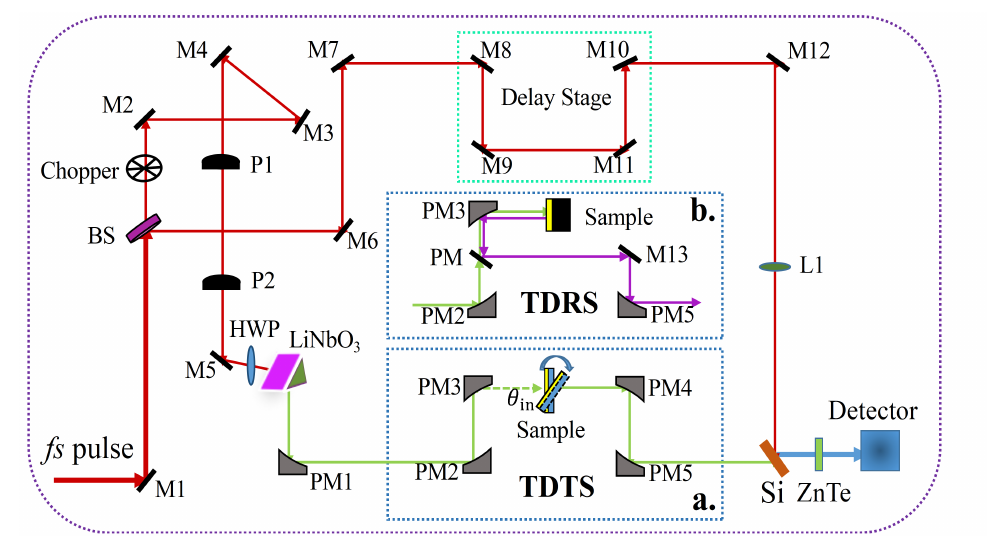
Figure 3. Experimental setup: BS: beam splitter; M1-13: metallic reflecting mirrors; HWP: half-wave plate; PM1-5: parabolic mirrors; PM: pellicle mirror; L1: convex lens; parts a and b: schematic diagram of the transmission (TDTS) and reflection geometry